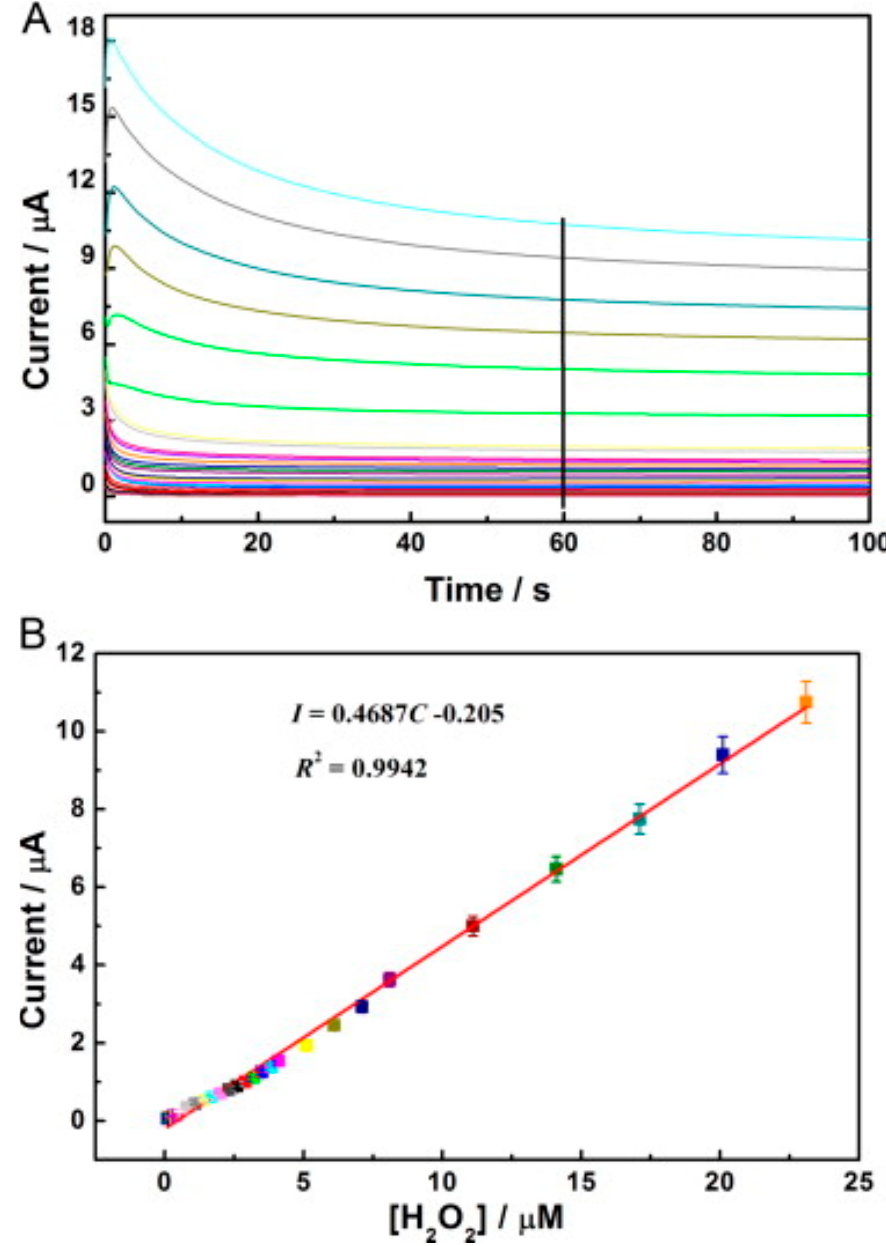
Figure 6. ( A ) Amperometric response of the HRP/C-Dots/LDHs/GCE to diverse concentrations of